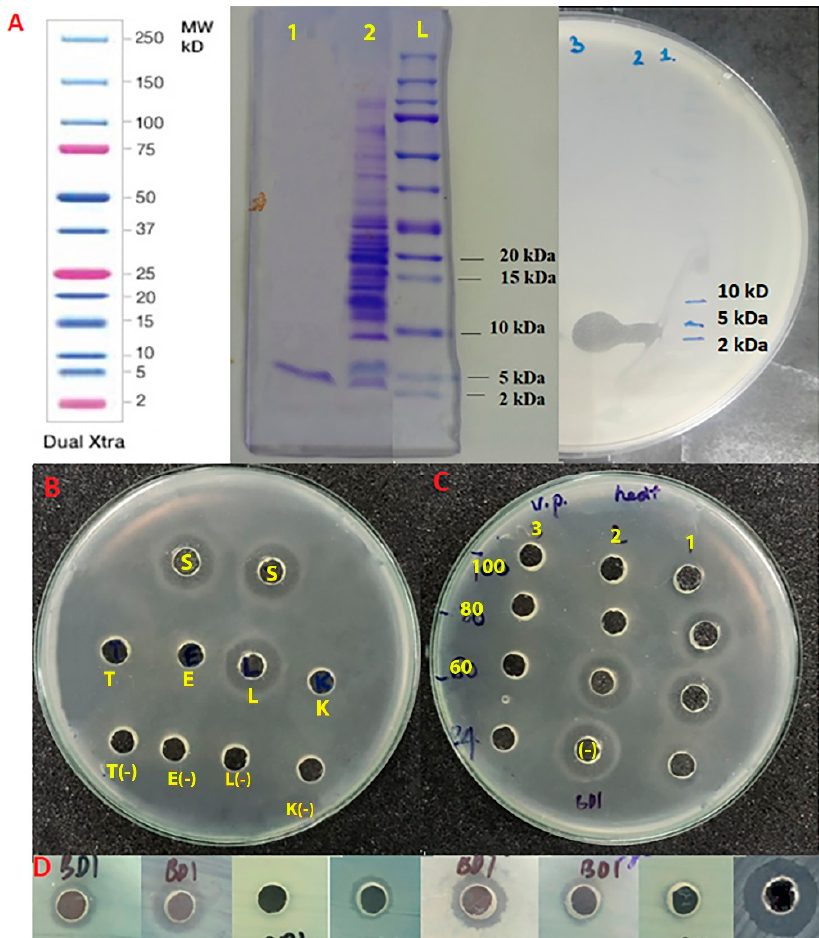
Figure 4. Properties of bacteriocin. ( A ) Molecular weight estimated by Tricine SDS-PAGE 16.5% gel (left) and Zymogram gel (right). Position of wells on gels included HPLC-based bacteriocin (1), bacteriocin crude extract (2), protein ladder (L). ( B ) Anti- Vibrio activity of bacteriocin after proteolytic treatment with pronase E (E), proteinase K (K), trypsin (T), and lysozyme (L). ( C ) Anti- Vibrio activity of bacteriocin after thermal treatment at 60 °C (60), 80 °C (80), 100 °C (100) for 15 min (1), 30 min (2), and 60 min (3). ( D ) The antimicrobial activity of bacteriocin evaluated by a well diffusion assay. The reference strains in the images (from left to right) included S. typhimurium , V. parahaemolyticus , E. coli , V. harveyi , B . cereus , S. aureus , MRSA, and L. monocytogenes.